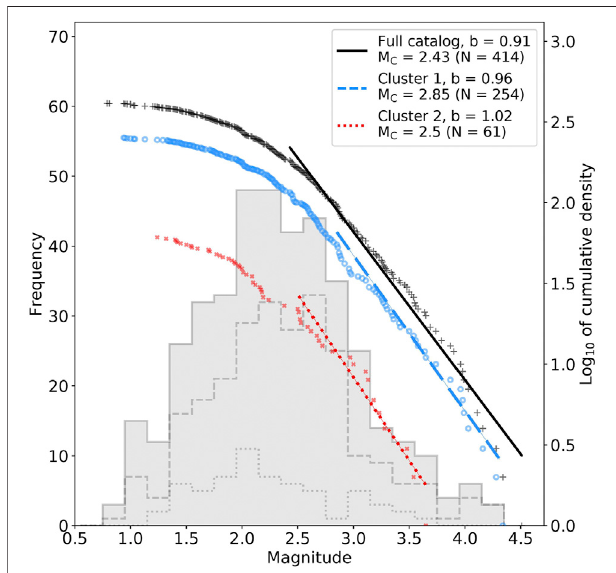
FIGURE 7 | Magnitude frequency distribution of earthquakes for full catalog, Cluster 1, and Cluster 2. Left axis (Frequency) shows the number of earthquakes in each magnitude bin. The magnitude bin used here is 0.2 magnitude units. Right axis (logarithm of cumulative density) depicts the cumulative number of earthquakes of magnitude M L and higher. The magnitude of completeness is calculated using the maximum curvature method (Wiemer and Wyss, 2000) applying 0.4 magnitude units upward correction. The b-values are calculated by fi tting the cumulative density function with a power-law above a magnitude